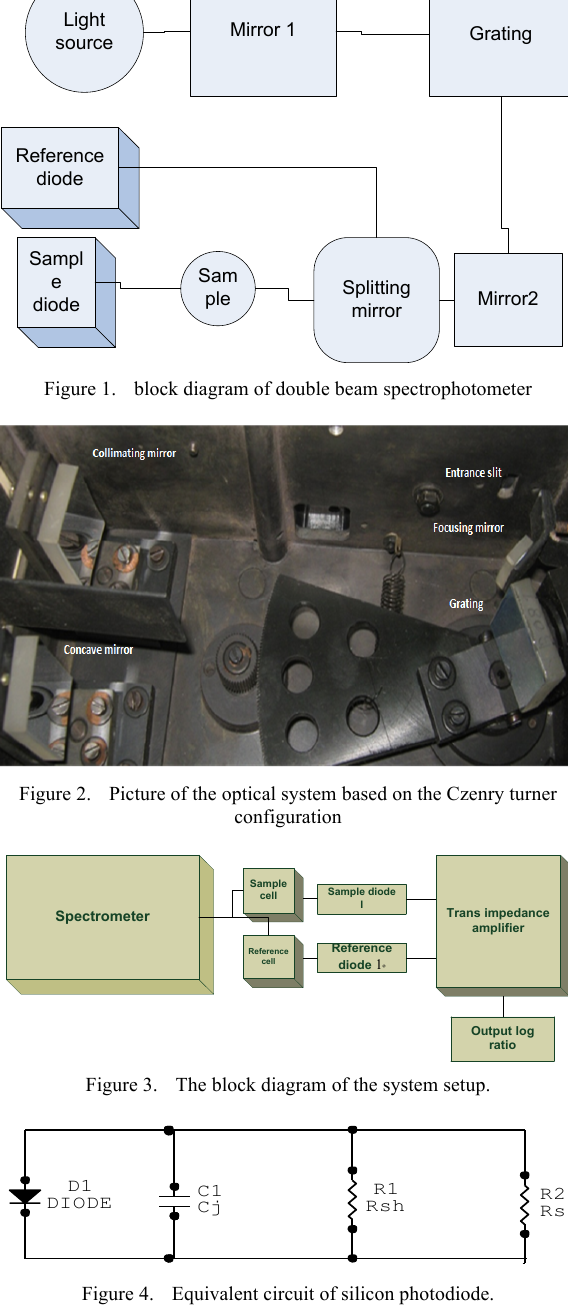
Figure 4. Equivalent circuit of silicon